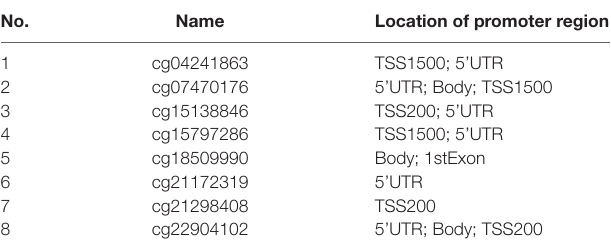
TABle 1 | CpG sites of N - acetyltransferase 1 ( NAT1 ) in the promoter region. no.